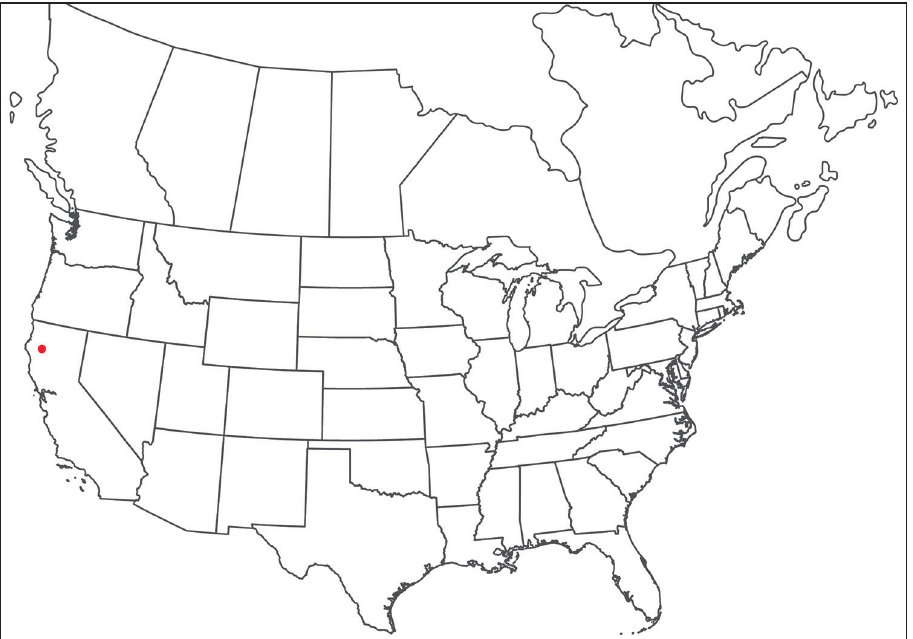
Figure 273. Torrenticola welbourni sp. n.